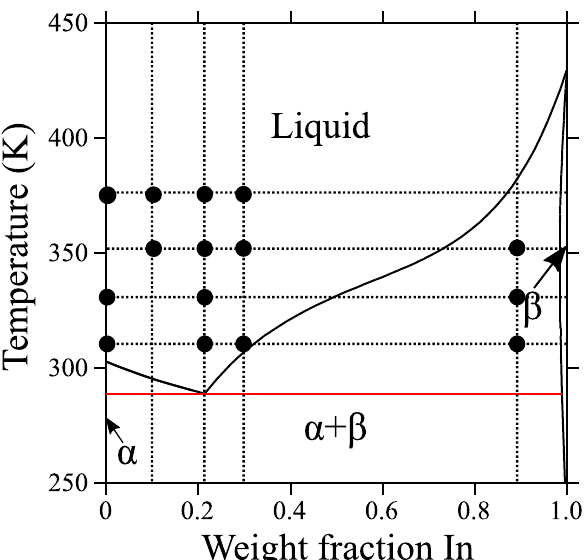
Figure 3. Calculated Ga-In phase diagram using the thermodynamic descriptions from [12]. The black points indicate the temperatures and compositions at which the thermal conductivity of Ga-In alloys were measured in the present work.